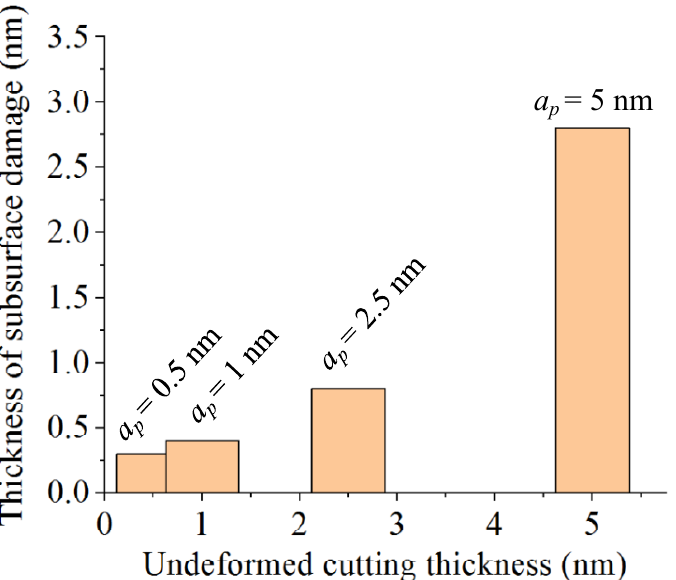
Figure 6. The variations of the subsurface damage with different undeformed cutting thicknesses.